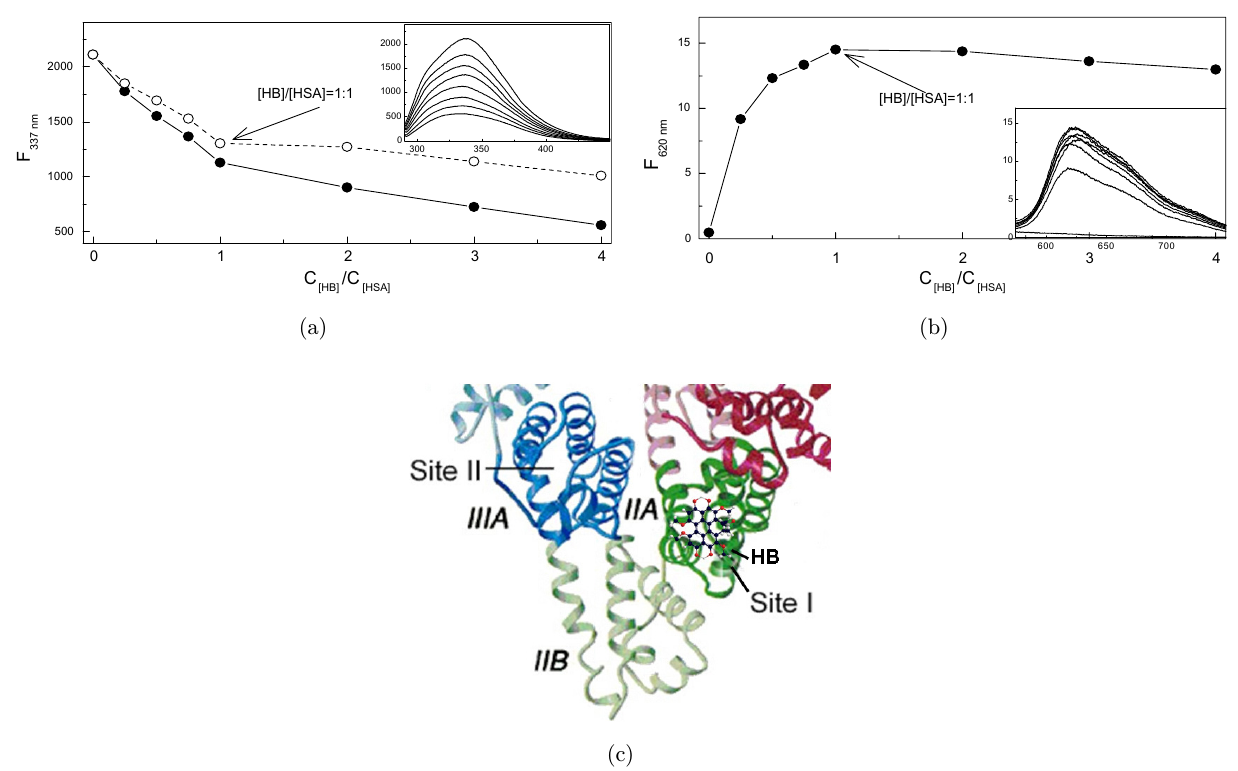
Fig. 7. The plots of the °uorescence intensity of the tryptophan at 337 nm (a) and HB °uorescence at 620 nm (b) to the ratio of concentration of HB to HSA (10 (cid:1) M) in PBS (pH7.4). (c) HSA structure and the speci¯c binding site.